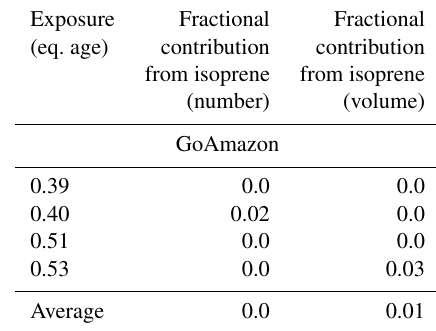
Table 5. Modeled fractional contribution of the measured initial iso- prene concentrations towards the total change in number and vol- ume between the initial and final number and volume size distri- butions modeled from the GoAmazon2014/5 campaign, using the best-fit S/IVOC estimate. (Isoprene was not included in the model for the BEACHON-RoMBAS distributions.) The remaining frac- tional contribution is attributable to the MT and S/IVOC concentra- tions in the model. Each exposure’s fractional contribution is calcu- lated using the averaged contributions of the six model cases with the lowest (best) NME values from the full model parameter